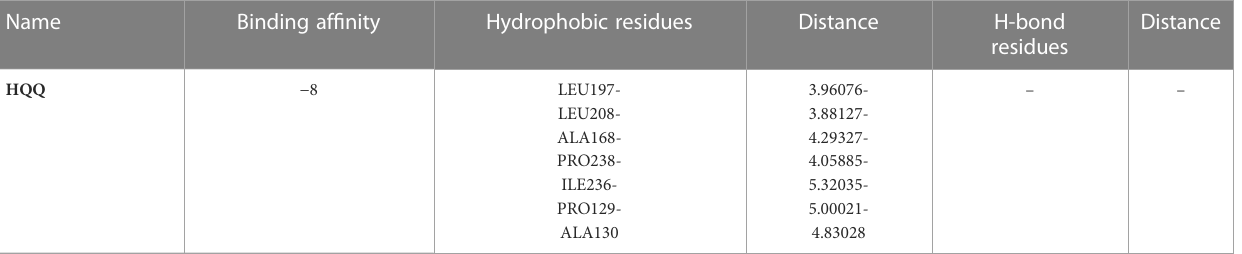
TABLE 3 Docking results of the proposed molecules with transcriptional regulator MvfR (PDB: